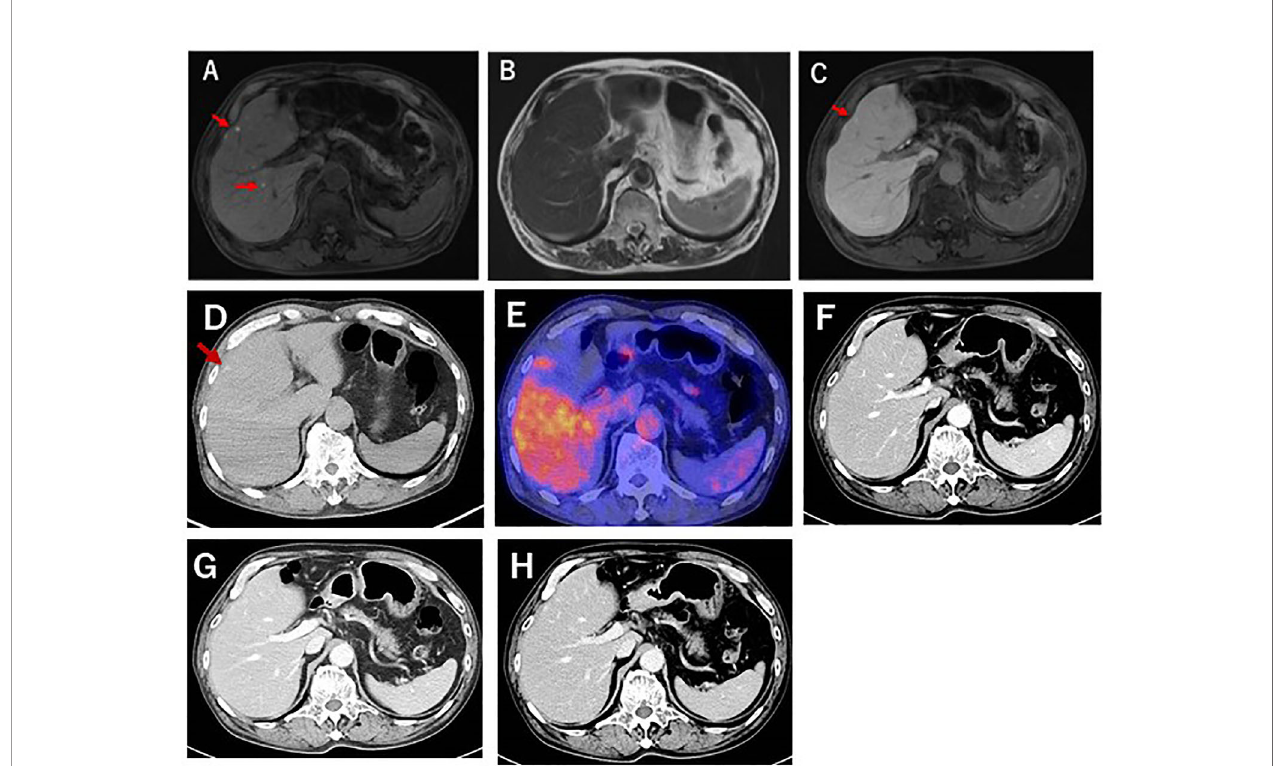
FIGURE 1 | Gd-EOB-DTPA enhanced MRI of this patient. (A) T1-weighted MRI showing that the liver nodules (red arrows) were highly intense. (B) T2-weighted MRI, showing that the liver nodules were iso-intense. (C) Gd-EOB-DTPA-enhanced MRI, showing the showed were highly intense during the hepatobiliary phase. (D) Plain-CT examination 1 year before liver biopsy, showing small, high-density nodules. (E) FDG-PET CT examination at liver biopsy. No abnormal FDG uptake was detected. (F – H) Dynamic CT examination during the (F) arterial, (G) portal phase, and (H) equivalent phases. No enhancement was